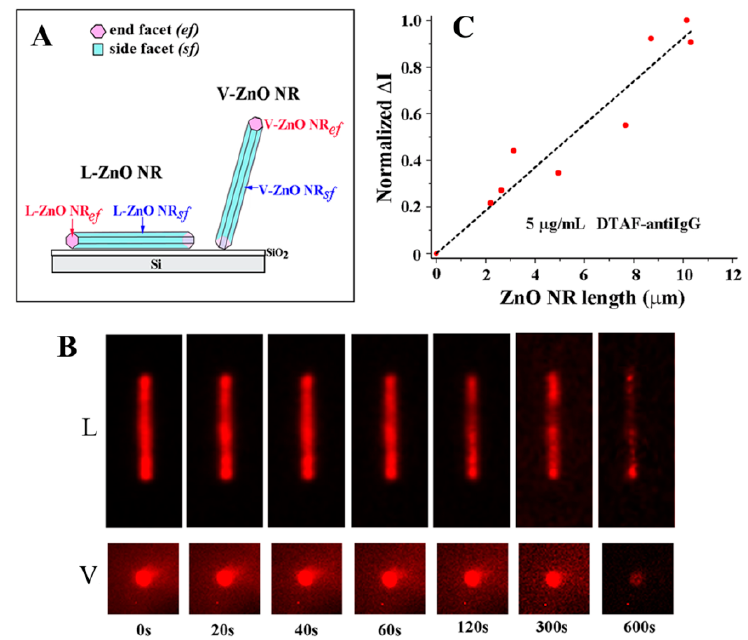
Figure 8. ( A ) The different growth orientations of the ZnO NRs are schematically shown; ( B ) The presence of FINE was confirmed for all cases when the spatial and temporal emission behavior of fluorophore-linked IgG antibodies, 1 µ g/mL TRITC-antiIgG, was monitored in time-lapse fluorescence panels, as shown for the case of a L-ZnO NR (top) and a V-ZnO NR ef (bottom). The magnitude and degree of FINE were much higher for V-ZnO NRs relative to L-ZnO NRs; ( C ) ZnO NRs of various lengths and widths were analyzed after treating them with IgG antibodies coupled to a different fluorophore, 5 µ g/mL of DTAF-antiIgG. In all cases, the difference in the normalized fluorescence intensity measured at the NR end versus NR side facets, ∆ I = I avg,NR ef − I avg,NR sf , indicated that the degree of FINE increased as the NR length became longer. The NR width did not lead to a significant effect. Reproduced with permission from Ref. [86] Copyright (2015) Royal Society of Chemistry.